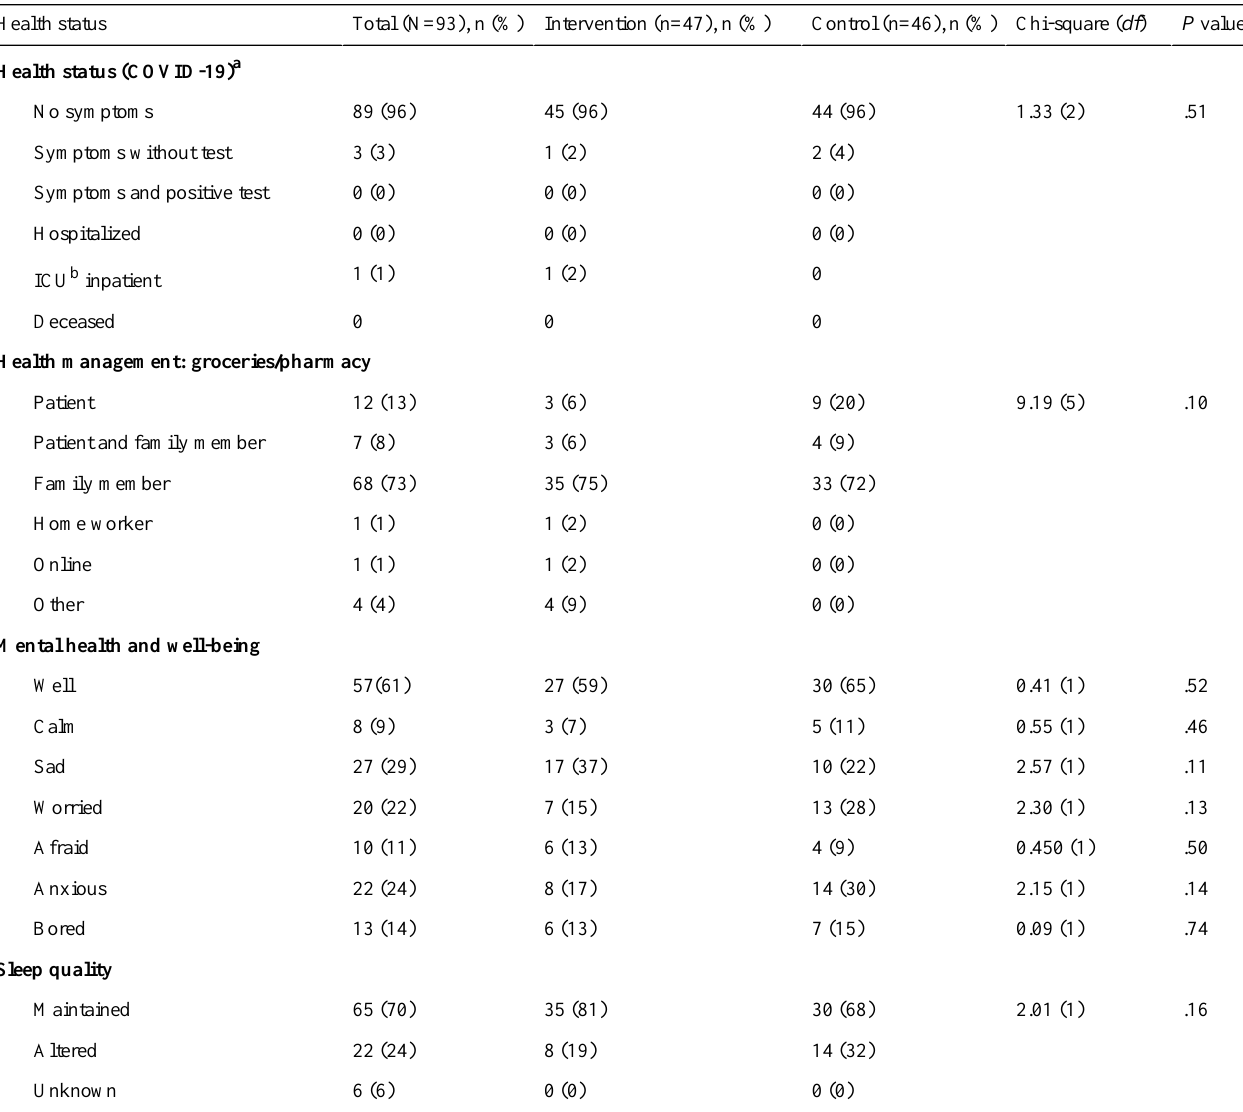
Table 2. Differences between the intervention and control groups regarding health status and management during the COVID-19